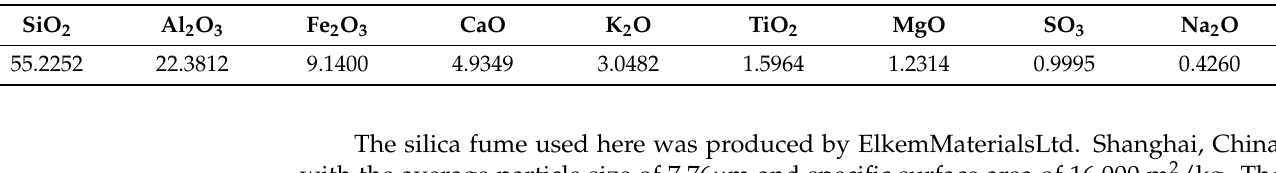
Table 4. Component of fly ash (%).